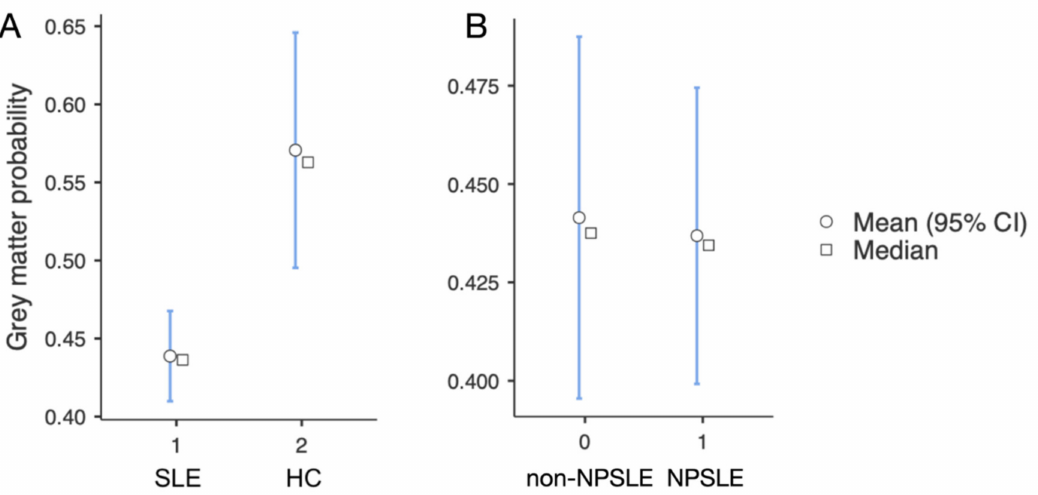
Figure 2. ( A ) SLE patients showed lower VBM values than HC in the left VIIIa. ( B ) No differences were found between the two groups of SLE patients (NPSLE (NeuroPsychiatric Systemic Lupus Erythematosus) and non-NPSLE) in this region. Values represent the mean values from the entire region depicted in Figure